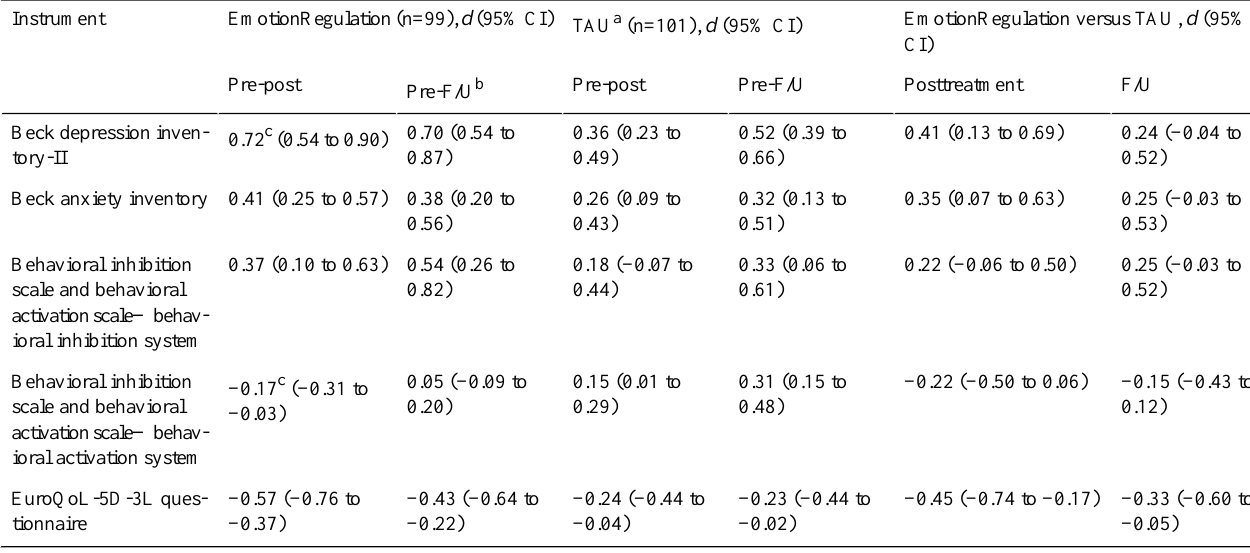
Table 4. Within- and between-group effect sizes and 95%